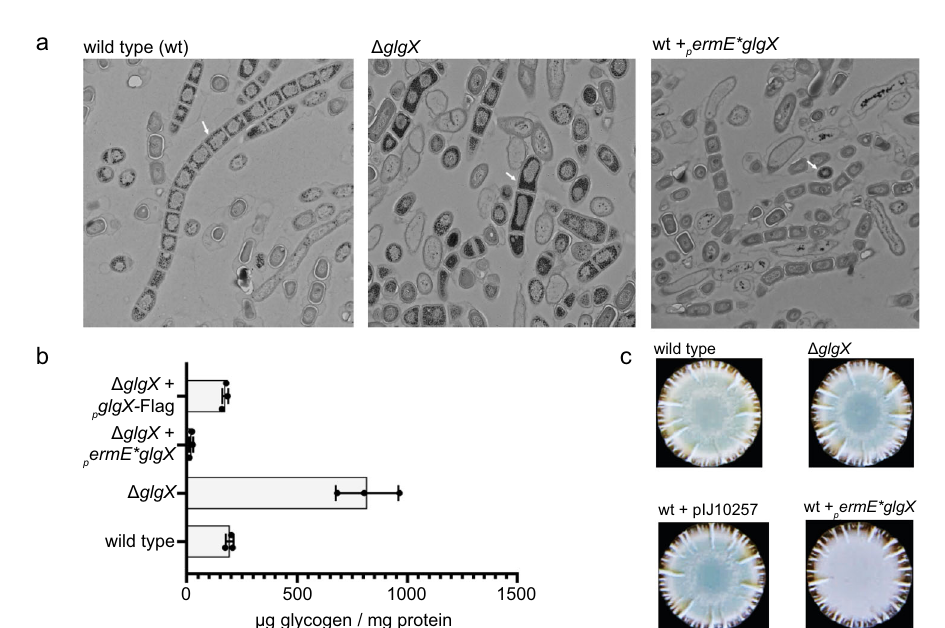
Fig. 2 | c-di-GMP stimulates glycogen breakdown activity of GlgX in vitro. a Bicinchoninicacid(BCA)invitroenzymeassay.Thepurplecopperbicinchoninate complex indicating GlgX-mediated generation of reducing ends in glycogen was quanti fi ed by photometric measurements at 562nm. A 562 values were converted into reducing ends [ µ M glucose equivalents] based on D -glucose as a standard. Reactions contained 0.05% (w/v) glycogen from rabbit, 1 µ M GlgX and increasing concentrations of c-di-GMP (0 – 100 µ M).Source dataareprovided asaSource data fi le. b BCA assay containing 0.05% of either glycogen from rabbit, pullulan,